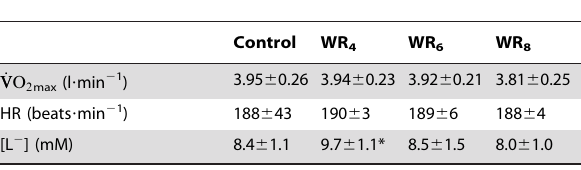
Table 1. _ VVO 2 max , HR and [L 2 ] attained at the limit of tolerance during Control, and fixed WR HIIT protocols performed at WR 4 , WR 6 and WR 8